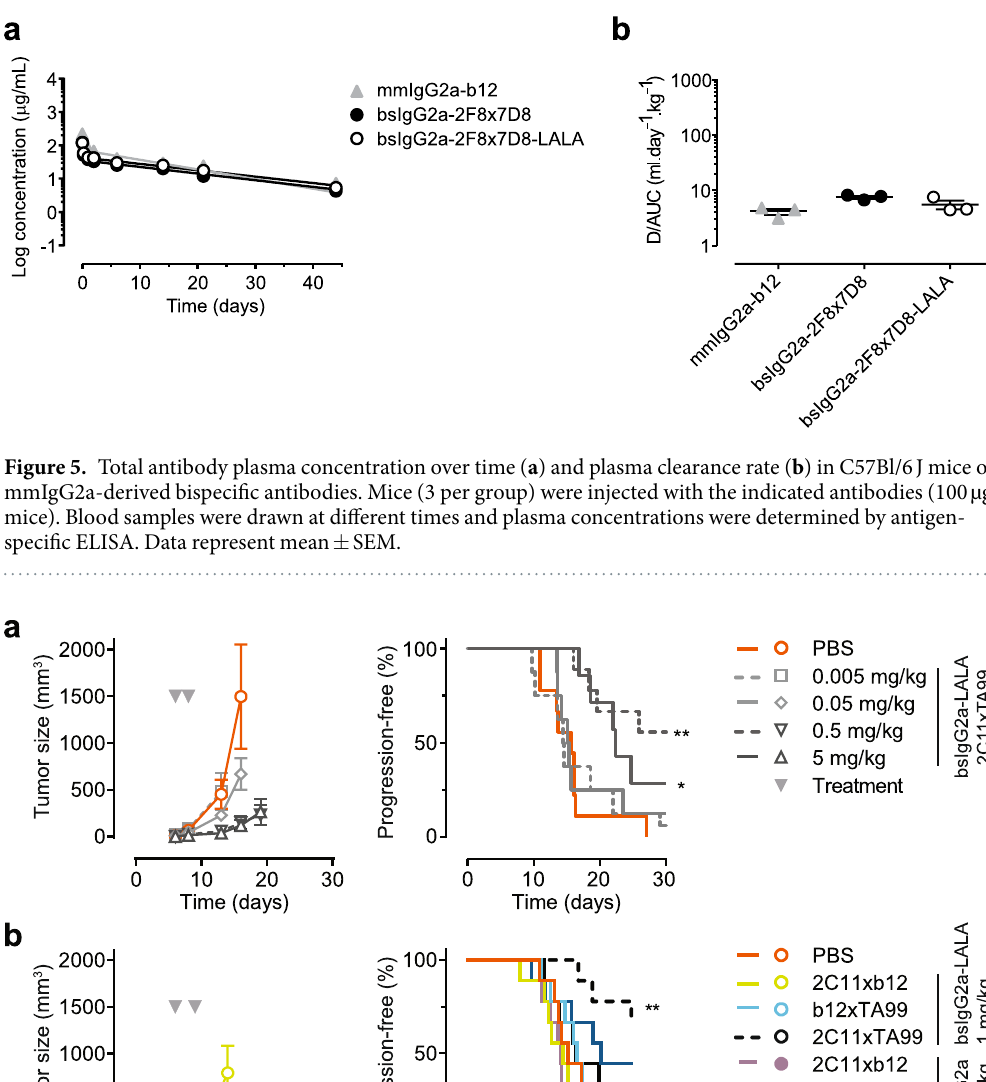
and compared to their effector function-silenced (inert) counterparts in the same model. At 1 mg/kg, both func- tionally monovalent active bsIgG2a variants (2C11xb12 and b12xTA99) showed no inhibition of B16-F10 tumor growth (Fig. 6b and Supplementary Fig. 3), similar to their corresponding inert bsIgG2a-LALA variants. In con- trast to the inert equivalent, the active bsIgG2a-2C11xTA99 displayed no significant anti-tumor activity. Toxicity was only observed in the two active bsIgG2a variants targeting T-cells (2C11xTA99 and 2C11xb12) as revealed by the loss of bodyweight in these treatment groups (Fig. 7a). All mice had recovered by day 14 (8 days after first dose) and did not become worse after the second dose, indicating that the effects were transient and initiated by the first dose. Analysis of the serum, taken 1 h after injection of the first dose, revealed elevated levels